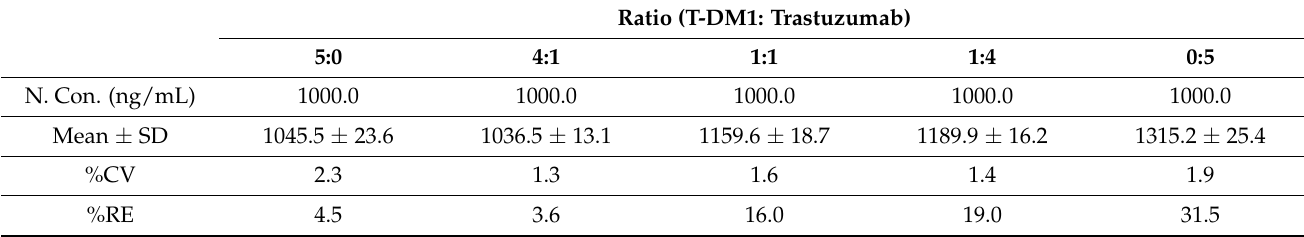
Table 2. Total trastuzumab ELISA results for samples containing both T-DM1 and trastuzumab.